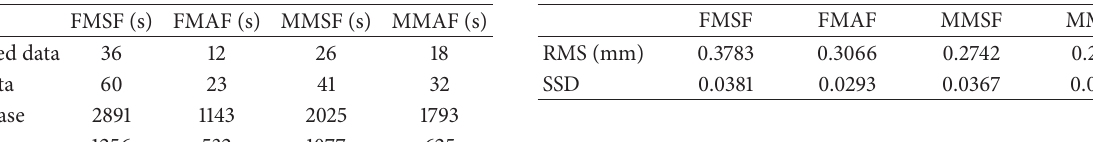
Table 1: Computing time of various methods. Table 2: Comparison of RMS and SSD for various